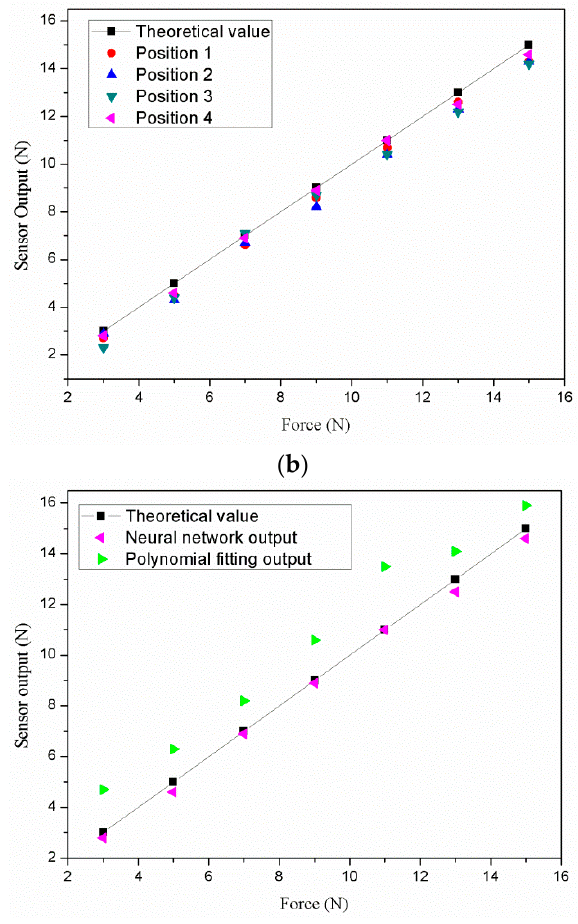
Figure 18. The results of the experiments. ( a ) The result of contact position detection; ( b ) the result of contact force detection; ( c ) comparison of the RBF neural network output with the polynomial fitting output.